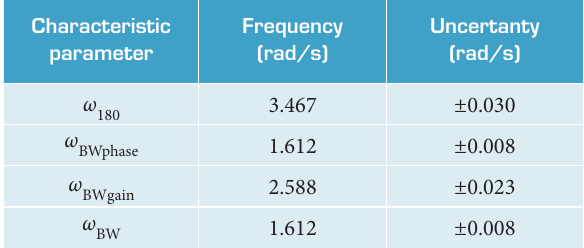
Table 1. AS355-F2 level flight (80 KIAS) longitudinal flying qualities ADS parameters.